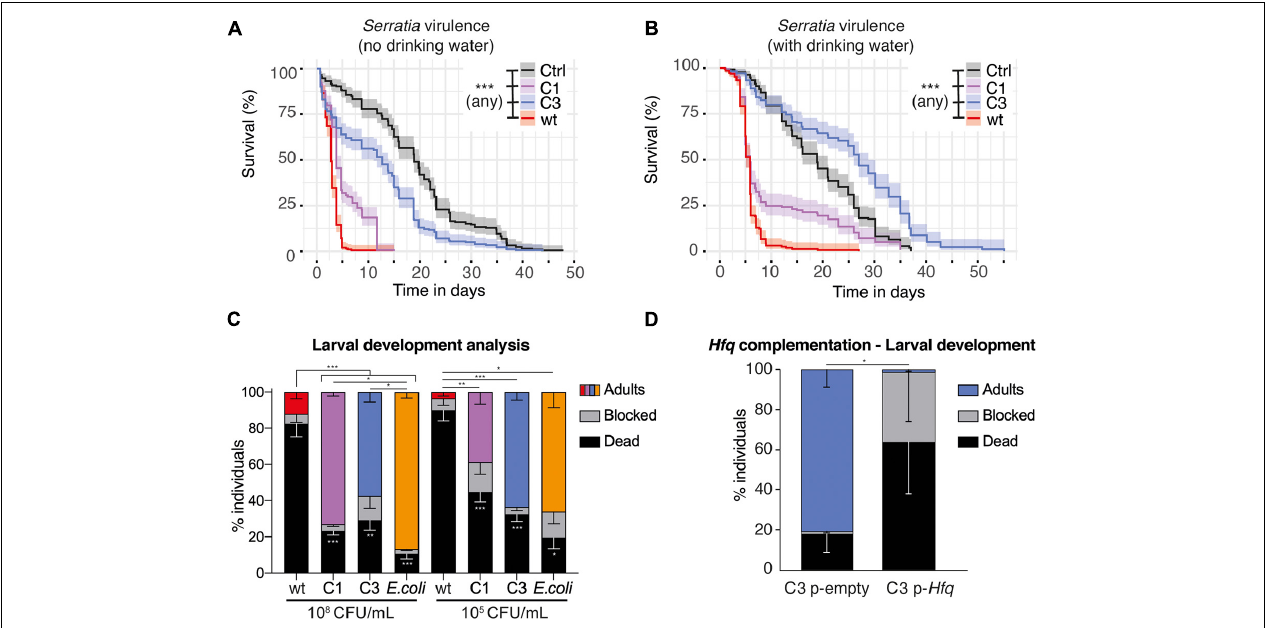
FIGURE 5 | Impact of S. marcescens VA on adult and larval Ae. aegypti . (A,B) Survival of adult females fed with a sugar solution contaminated with a concentrated suspension of S. marcescens (OD 600 nm = 80). In (B) , mosquitoes were provided with drinking water in addition to the infectious meal. (C,D) , Development success to adulthood of larvae contaminated with S. marcescens from the first larval instar. In (C) , the concentration of the bacterial suspension at the beginning of the experiment is indicated below. CFU, colony forming unit. In (D) , larvae are provided with C3 carrying an empty pBBR1MCS-2 plasmid or an Hfq -containing pBBR1MCS-2, at a 10 8 CFU/mL concentration. Data show the results of 2 (A,B) , 7 (C) , and 3 (D) independent replicates. Confidence intervals are shown in (A,B) and SEM in (C,D) . * p < 0.05; ** p < 0.01; *** p < 0.001.